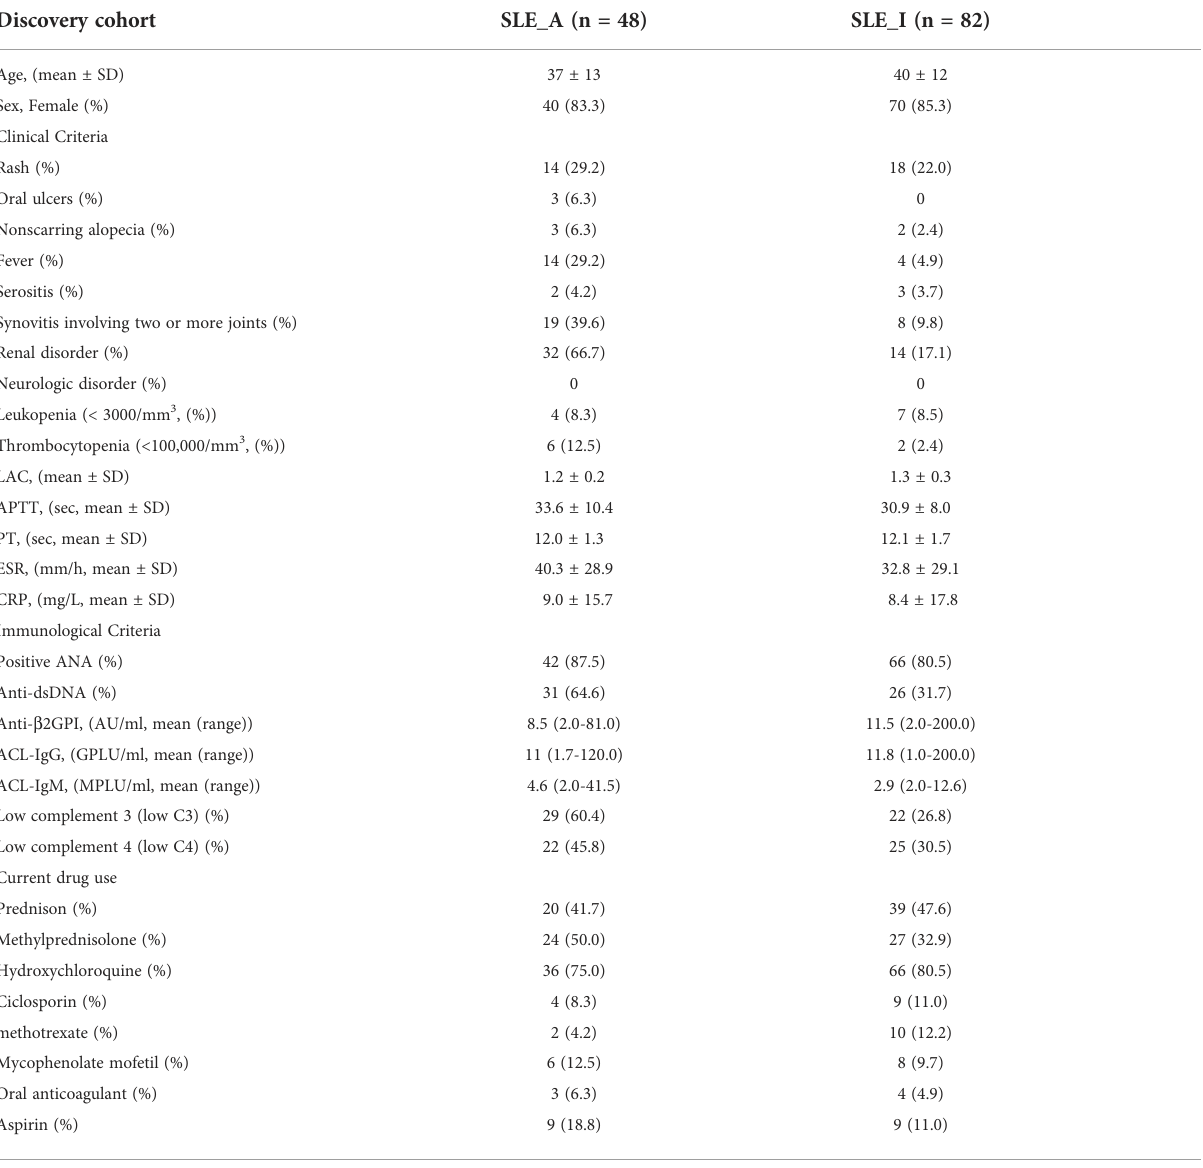
TABLE 1 Clinicopathologic characteristics of the SLE patients from discovery